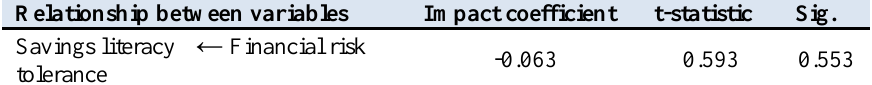
Table 5 . Estimation of the coefficients of the second hypothesis